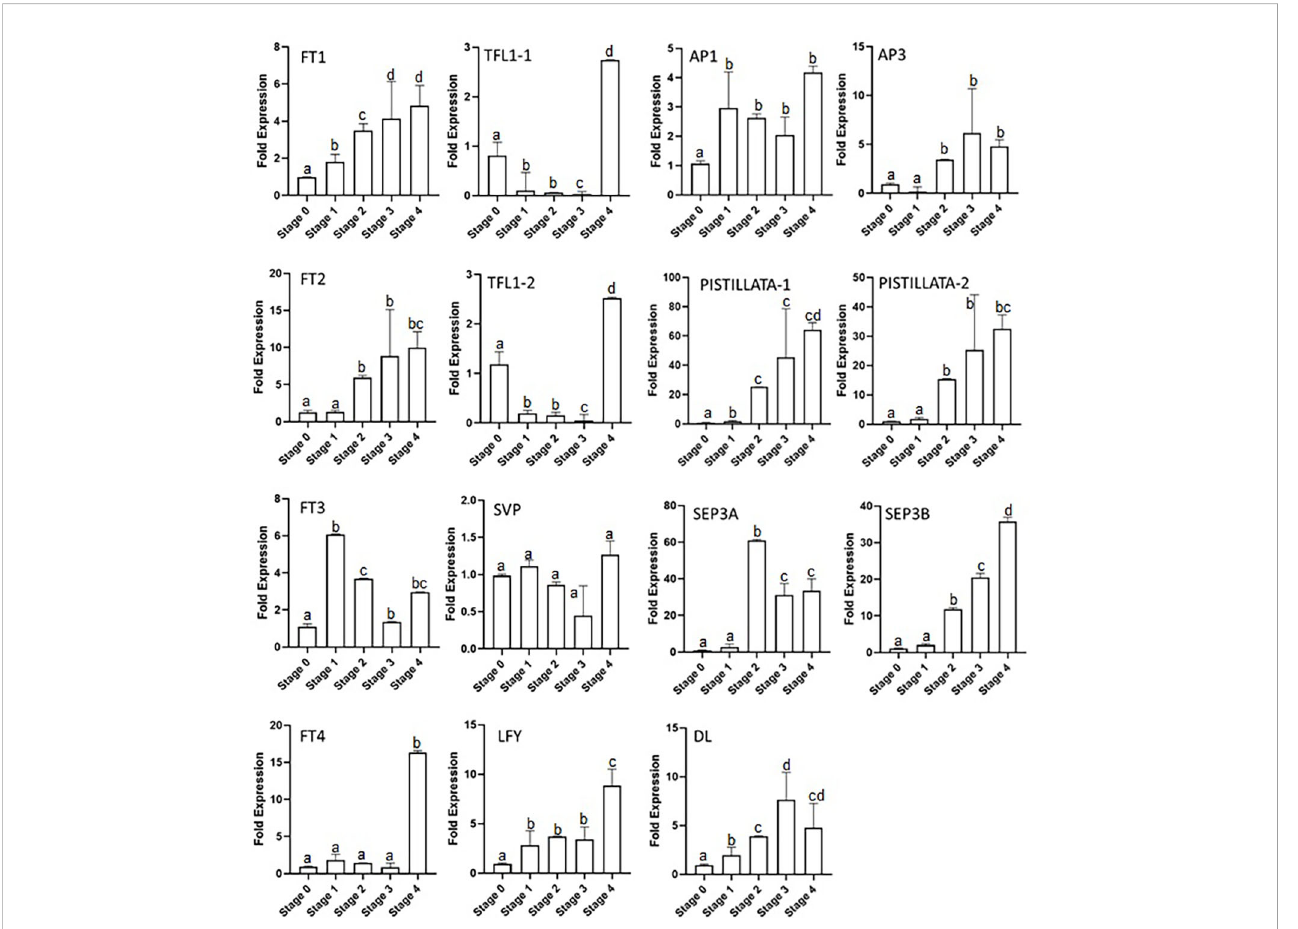
FIGURE 3 Expression pro fi ling of fl oral integrator and homeotic genes at different developmental stages of saffron fl owering. Stages 0 – 4 represent different developmental stages during saffron fl owering. Stage 0, dormant corms; stage 1, fl ower induction stage; stage 2, stamen and stigma formation; stage 3, stamen and stigma development and elongation; and stage 4, tepal development. Error bars represent ± SD of three biological replicates. Stage I morphologically represents the fl ower induction stage, and stage II represents the stamen and stigma formation stage. Letters (a – d) over the bars indicate signi fi cant differences at P < 0.05 (means followed by the same letter are not signi fi cantly different at P =